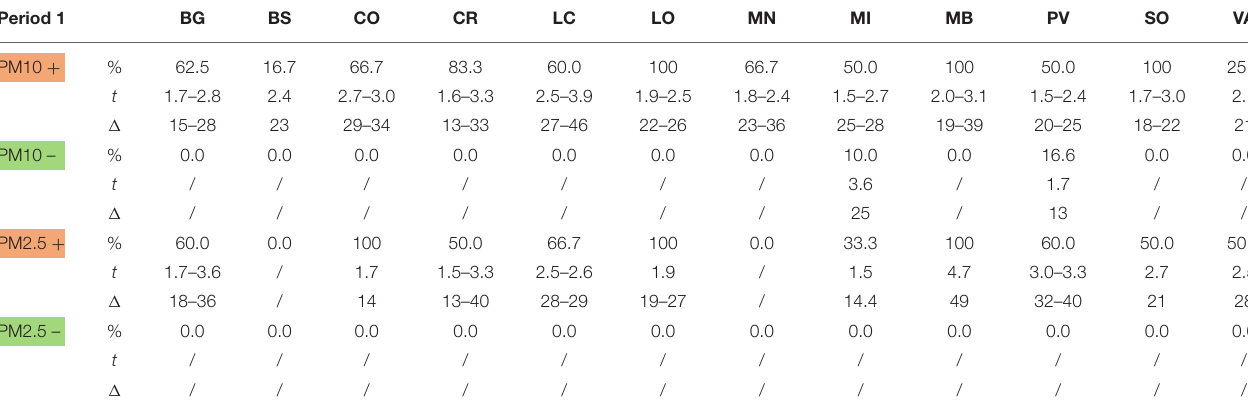
TABLE 2 | Comparison between the average concentrations of PM10 and PM2.5 in period 1 (9 March − 18 May 2019 and 2020). Period 1